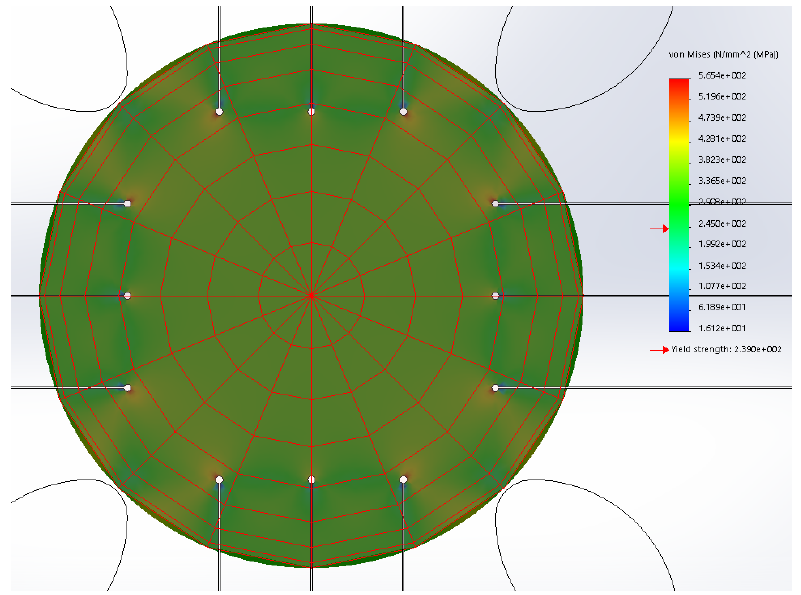
Figure 29. Central region for stress distribution analysis using the von Mises condition of plasticity in the final step of the simulation .